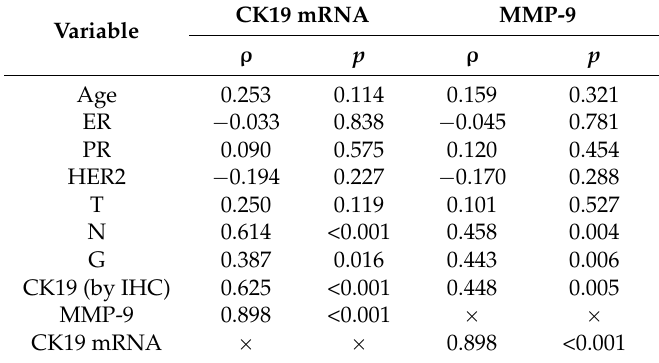
Table 5. Correlation between Spearman’s coefficient of correlation and Pearson χ -square values for CK19 mRNA and MMP-9, and analyzed clinicopathological features. CK19 mRNA Variable